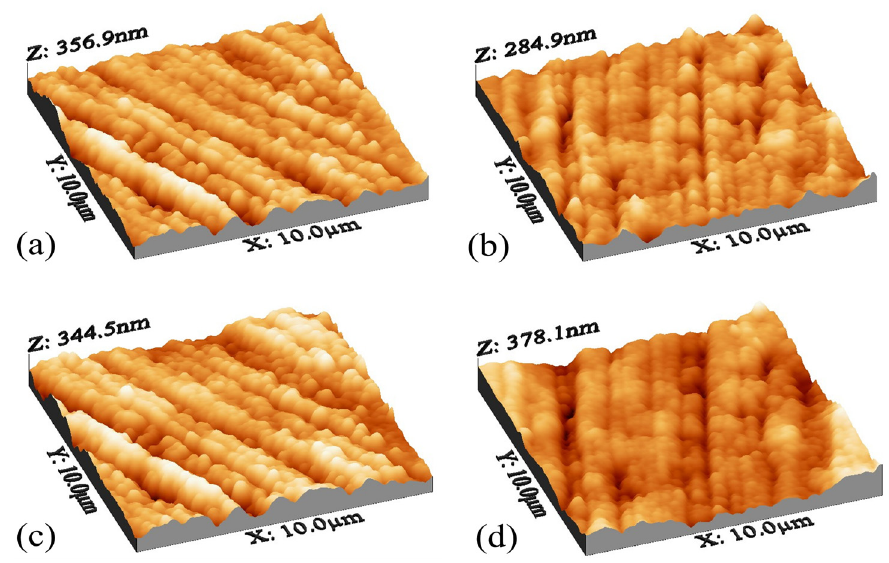
Figure 5. AFM analysis for modified membranes for ( a ) 0.001, ( b ) 0.002, ( c ) 0.005, and ( d )